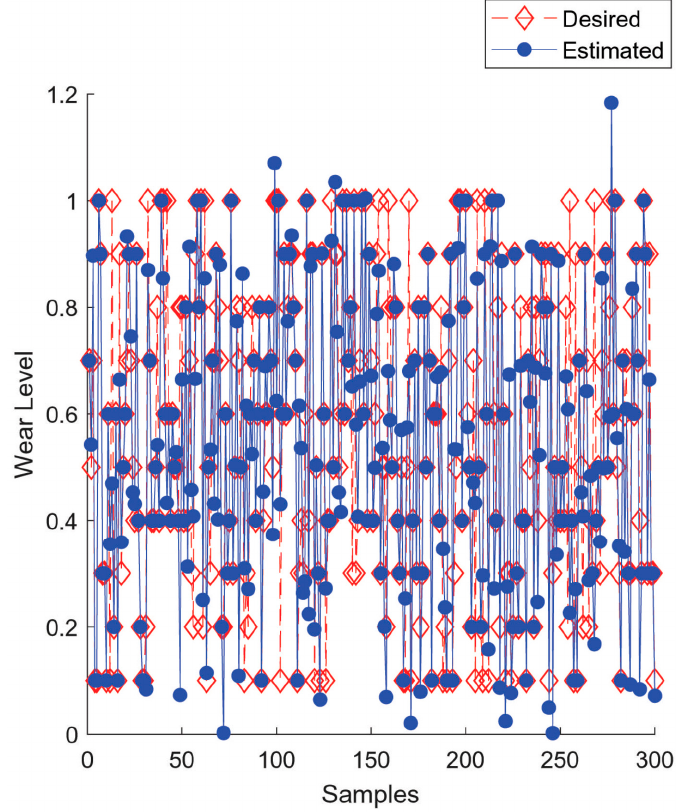
Figure 9. Neural estimator—wear evolution of a bearing fault—Inverter-fed.